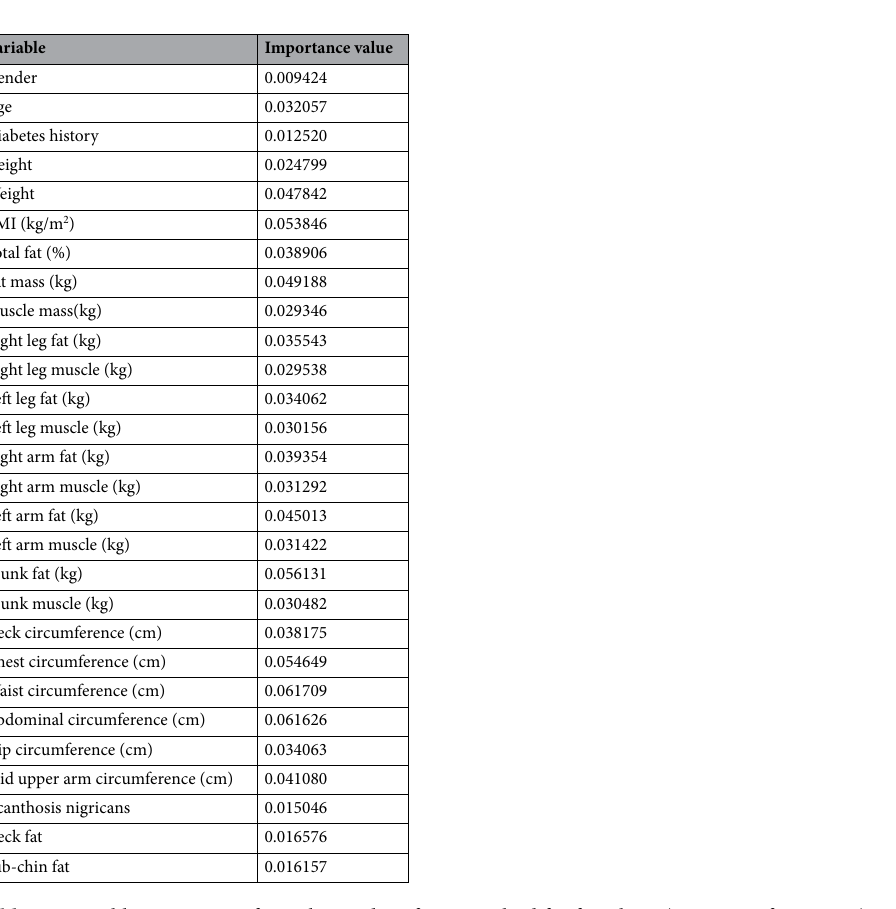
Table 4. Variable importance from the random forest method for fatty liver (presence of any